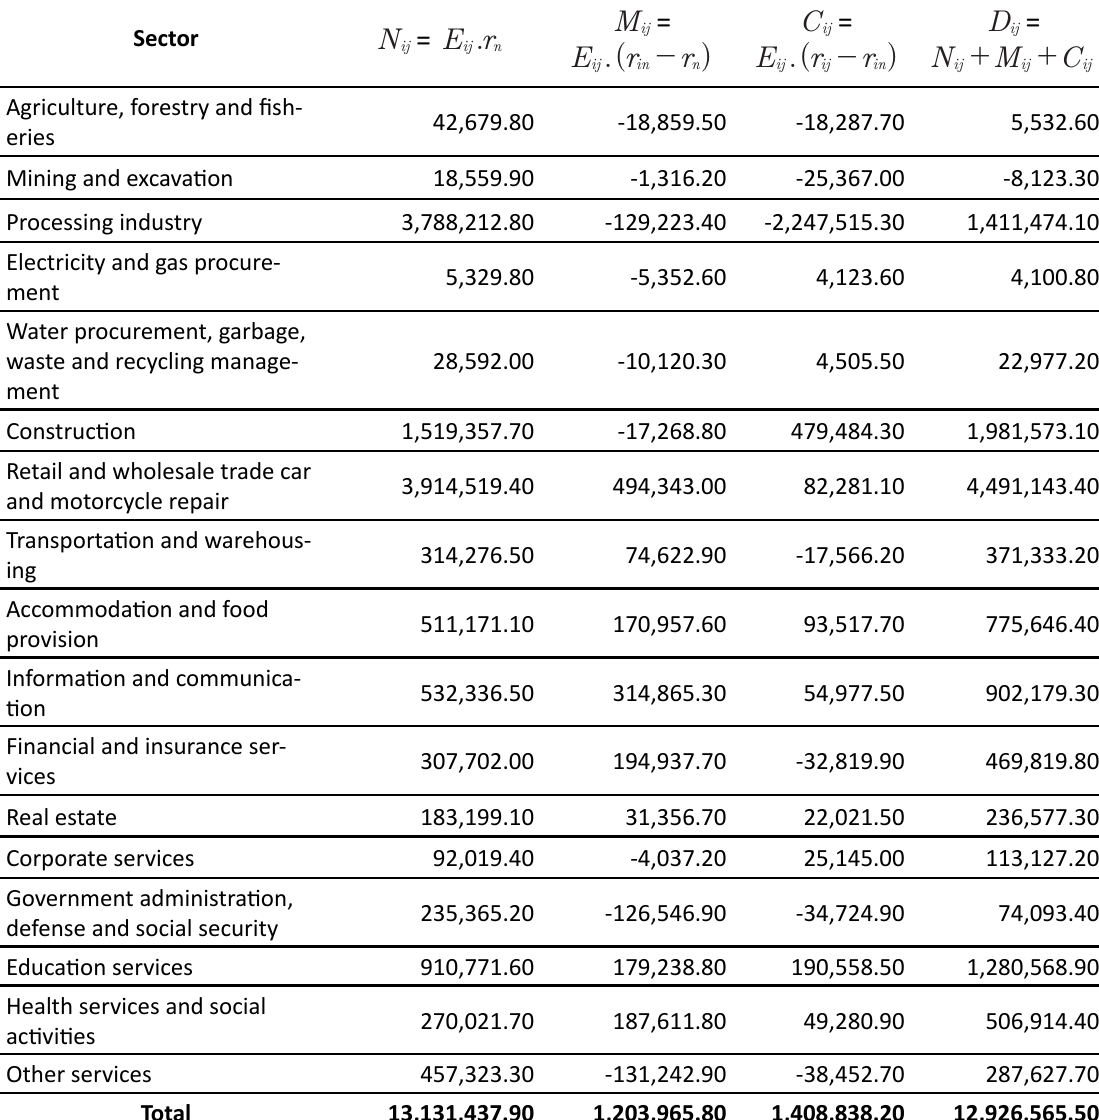
Table 1: Calculation Results of Shift Share in Malang City 2010-2016